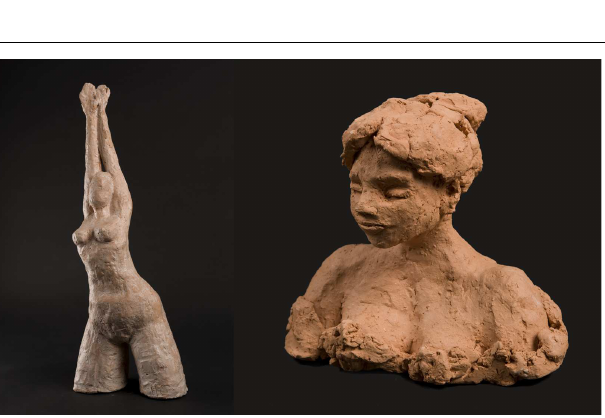
FIGURE 5 | Resumption of a calm and satisfying creativity